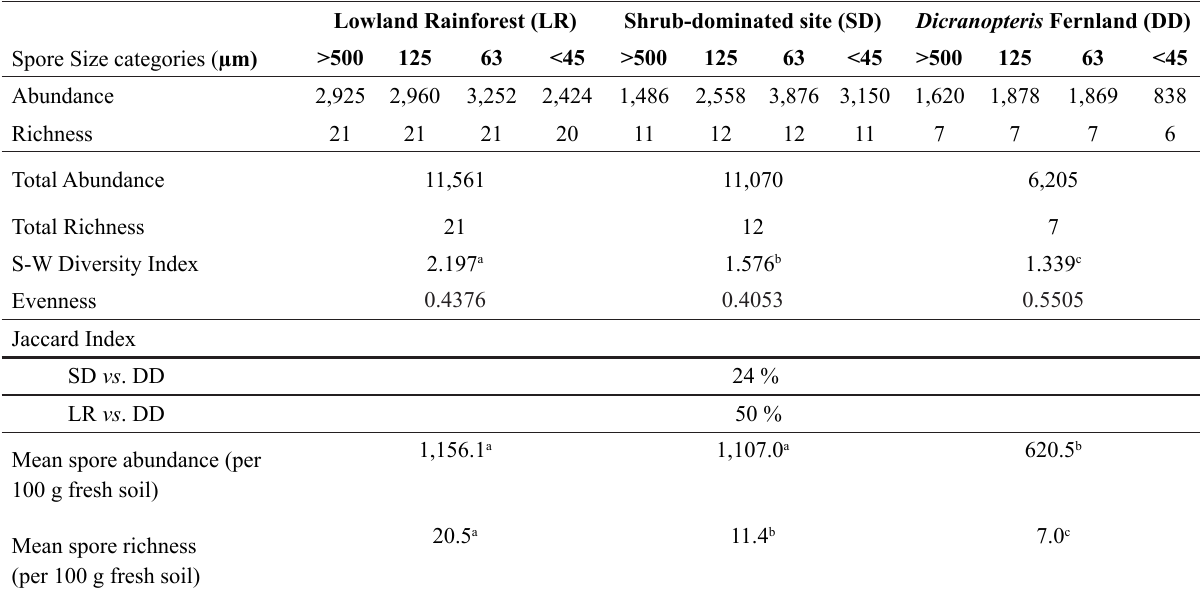
Mean Spore Richness, n = 10, F = 932.67, p = 0.000.